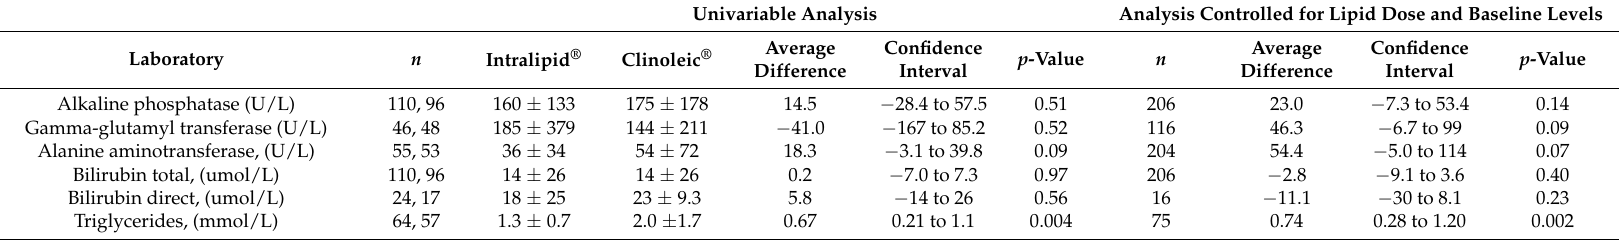
Table 3. Liver biochemistry, bilirubin, and serum triglycerides by lipid type, Intralipid ® versus Clinoleic ® , after 2 weeks of parenteral nutrition *.